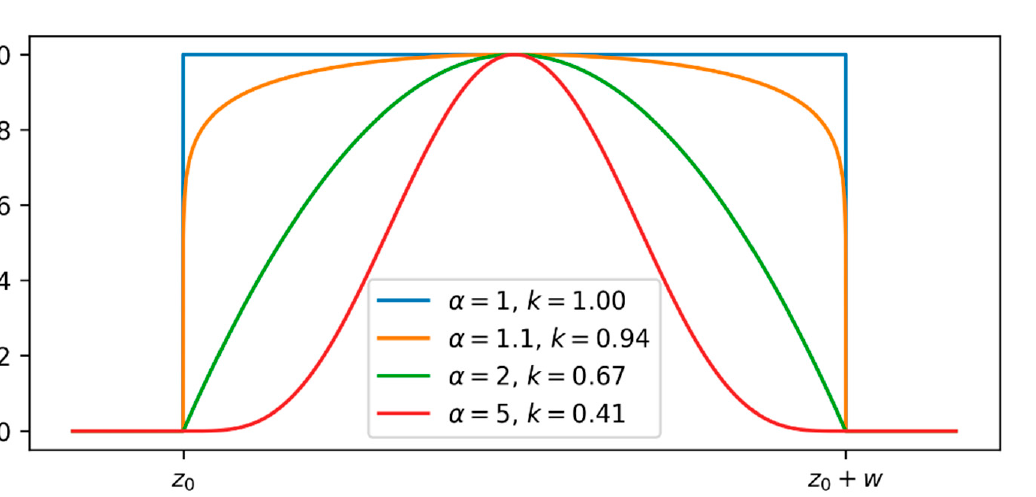
Figure 7. Results of the “direct water-leak estimation” in the case of a strong reflected pulse: ( a ) measured and fitting signal; ( b ) estimated capacitance profile. When the signal reflected at the water leak is weak (case (c) of Figure 4), results are of the kind illustrated in Figure 8. The region where water is present is still recognizable from the fitted capacitance profile, since it corresponds to its highest peak. However, the magnitude of the peak is not so high with respect to the fluctuations in the profile due to the non-idealities of the SE; the detection and the localization are clearly prone to